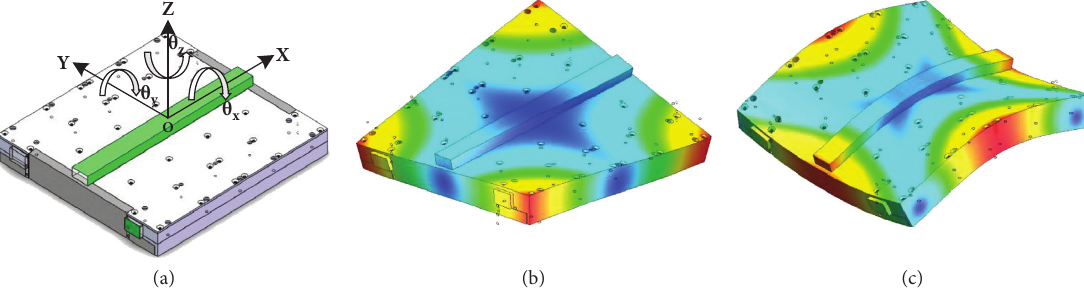
Figure 1: Rigid-flexible, coupled, multi-DOF motion system. (a) 6 DOFs rigid modes. (b) The first-order flexible mode. (c) The second- order flexible